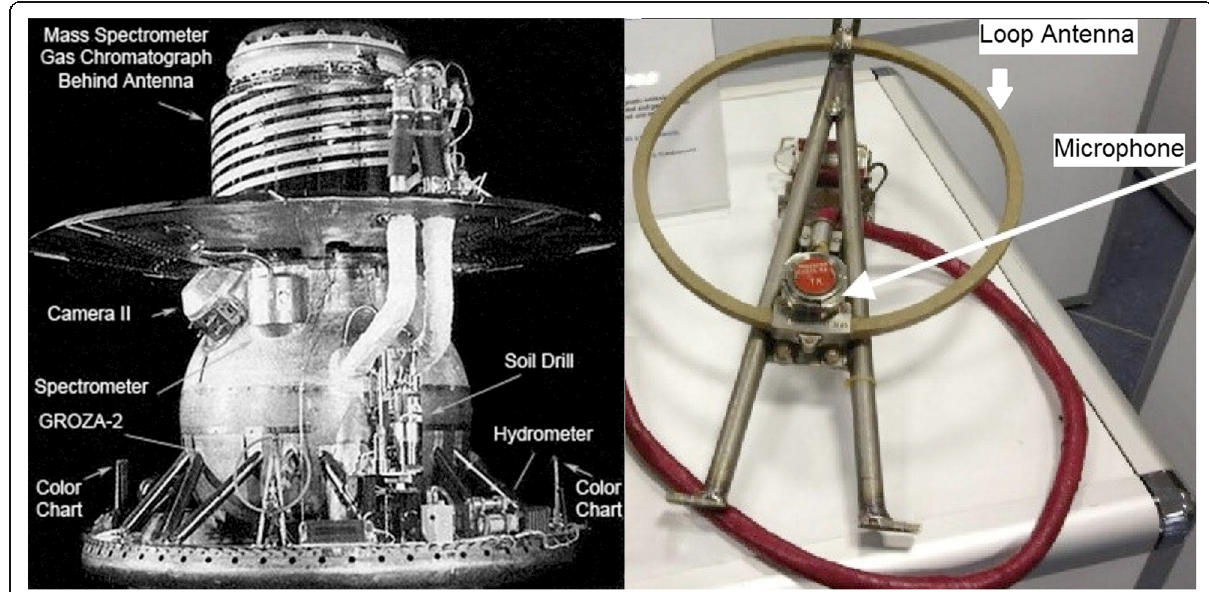
Fig. 6 The Venera 13 lander (left) with major systems noted (figure courtesy W. Huntress) — the GROZA-2 label points to the location of the loop antenna mounted externally just above the shock-absorbing landing ring. The disk structure near the top stabilized the probe during descent after the parachute was released. The GROZA-1 instrument is shown at the right (figure courtesy L. Ksanfomality) showing the loop antenna and mounting strut, together with a microphone for detecting thunder — note the heavy-duty insulation on the cable to protect it from the hot corrosive Venus